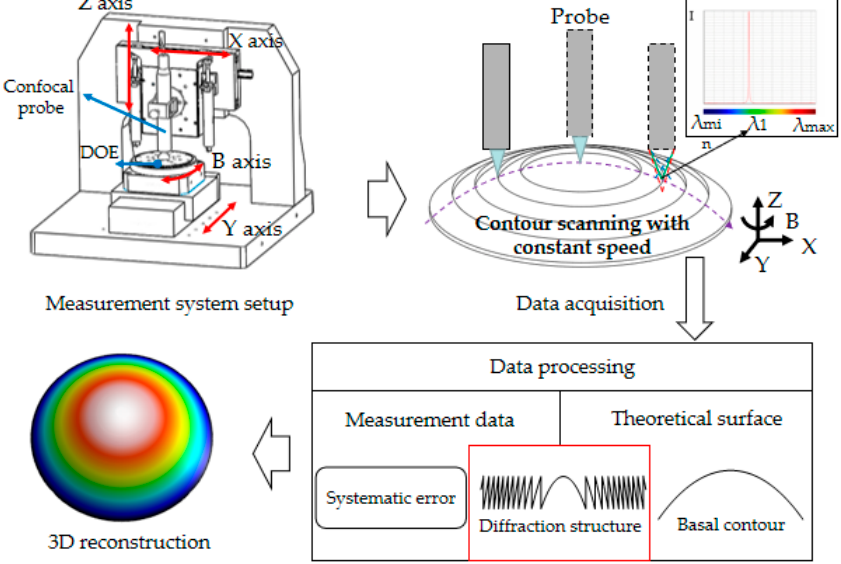
Figure 1. A schematic diagram for the measurement of a curved substrate diffractive optical elements (DOE).